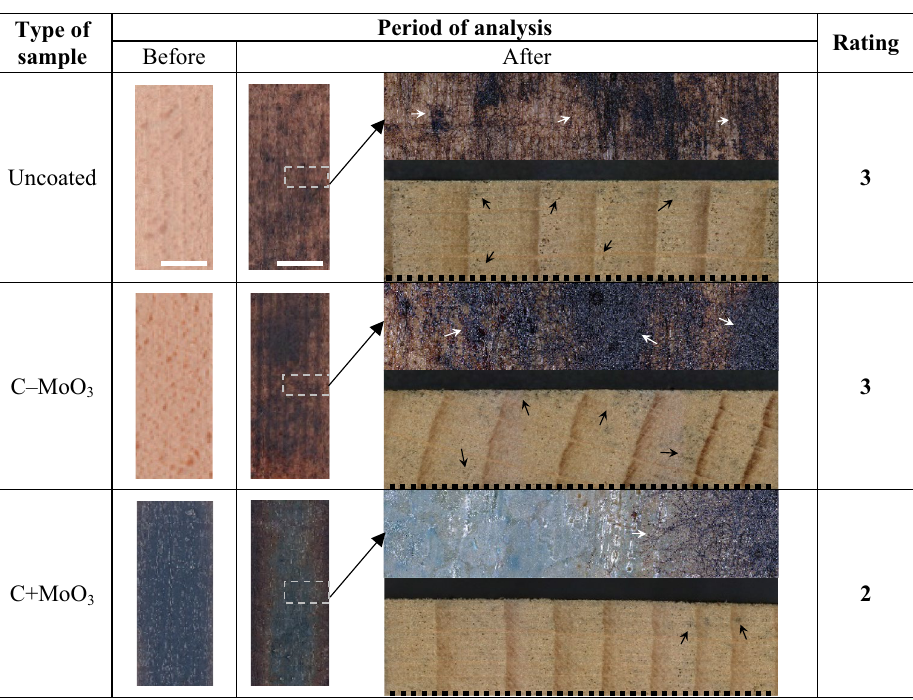
Period of analysisType of